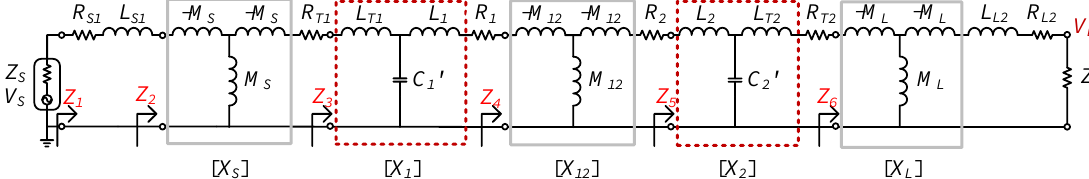
Figure 1. ( a ) Illustration of the proposed wireless power transfer (WPT) system and ( b ) its equivalent circuit.